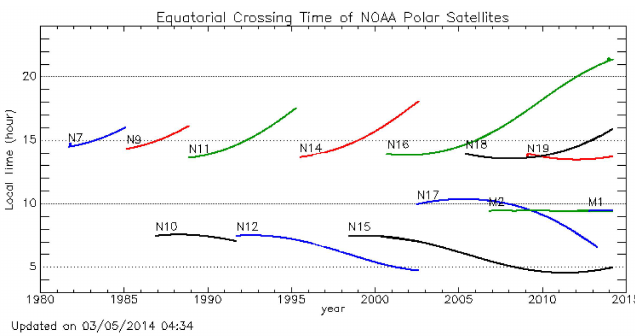
Figure 1. Equatorial crossing time (ECT) of NOAA POES